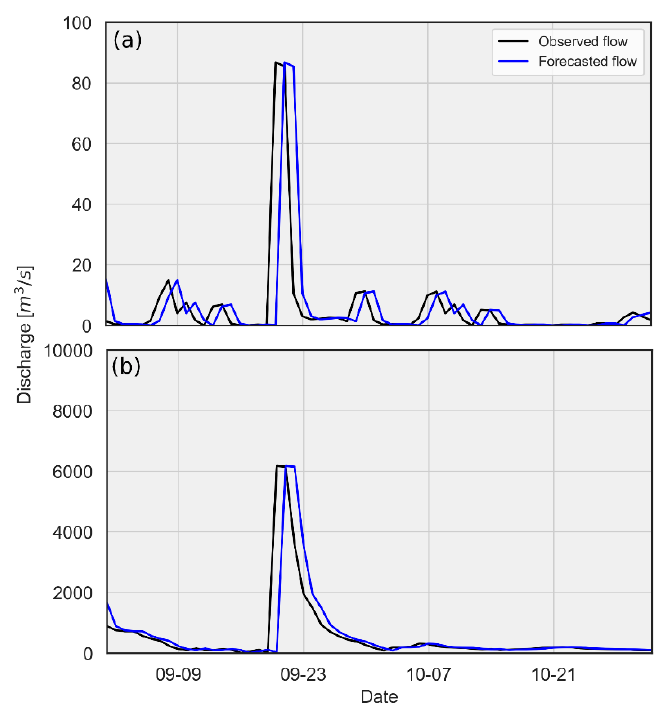
Figure A5. Demonstration of observed and forecasted stormflow hydrographs for the largest rainfall-runoff event of the year 2008 between 9/1/2008 and 11/1/2008 based on simple persistence for two basins shown in Figure A2 at a lead time of one day: Langurkhola in Chhana (159 km 2 ) and Karnali river in Chisapani (42,890 km 2 ), respectively.